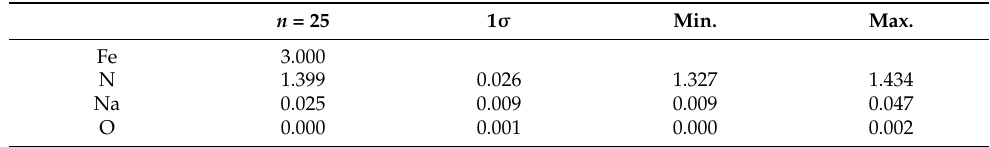
Table 4. Average elemental composition of siderazot grains from electron microprobe analysis averaged over 25 spots as given in Table 1, normalized to a composition of Fe 3 N 1+ x . n = 25 1 σ Min. Max.